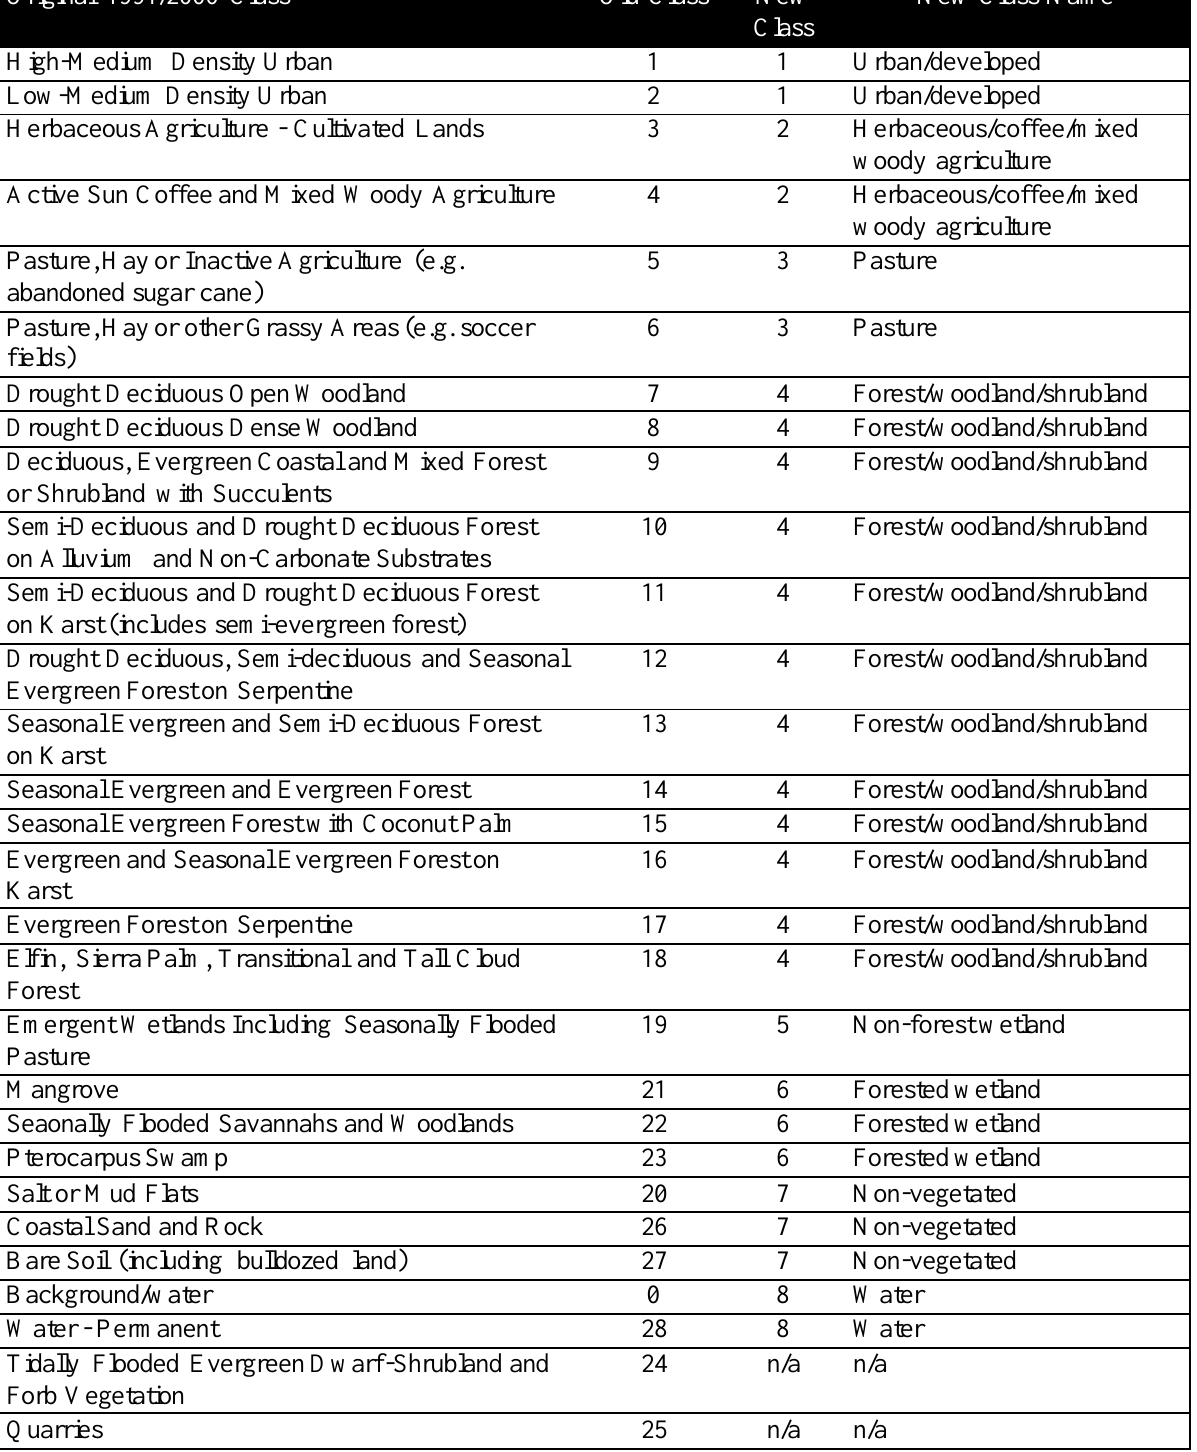
Table A2: Class conversions from the original 1991 and 2000 maps . The twenty-nine land-cover classes in the 1991 and 2000 land-cover maps created by Kennaway and Helmer (2007) were reduced to eight classes in our analysis, following the same methodology as Crk et al .